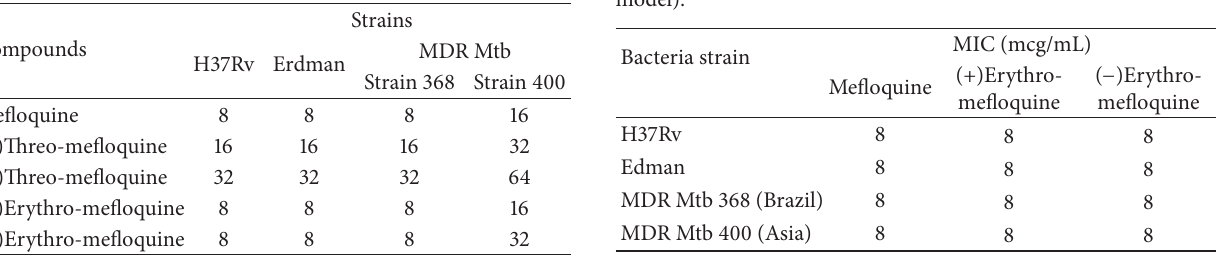
Table 1: Mefloquine and enantiomers MIC against two strains of MDR M. tuberculosis and H37Rv and Erdman strains. Results in mcg/mL.